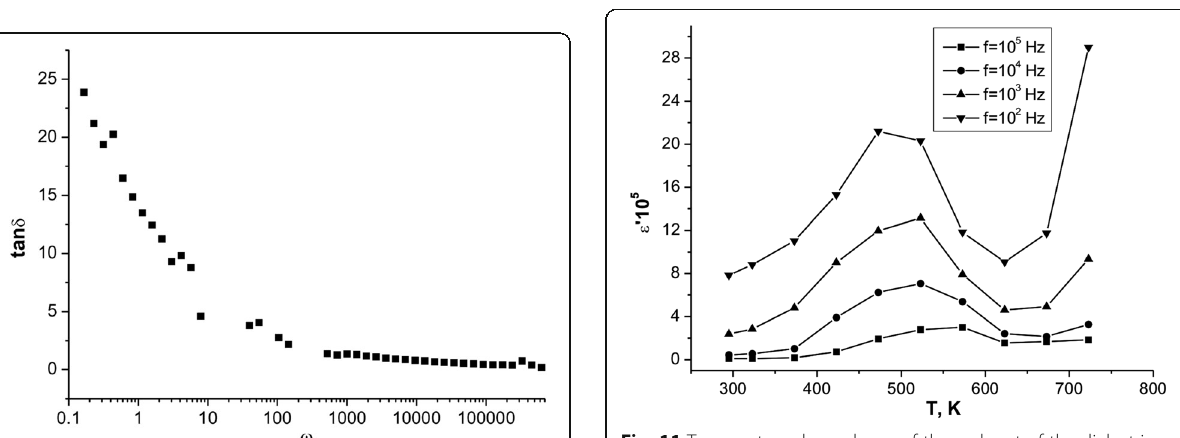
Fig. 11 Temperature dependence of the real part of the dielectric constant of the system at different